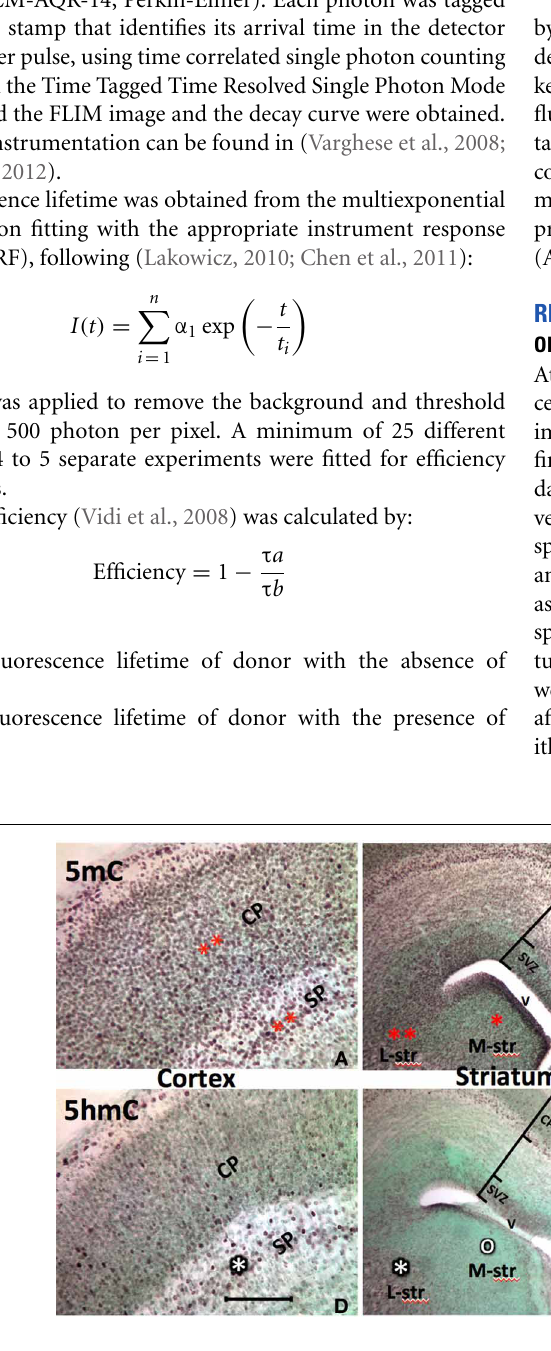
one red star area), and continue in the differentiating neurons in cortex (A) , lateral striatum (L-str, B ), and CA regions ( B , two red stars). The 5hmC arrives in the cells initiated for differentiation, and the level of 5hmC parallel with the stage of differentiation, e.g., subplate > cortical plate (D) , lateral striatum (L-str) > medial striatum (M-str) ( E , white star), CA1 > neuroepithelium ( F , white star). Counterstaining, methyl-green (green color). SVZ, subventricular zone; CP, cortical plate; SP, subplate; NE, neuroepithelium; V, ventricle; DG, dentate gyrus. Scale bar: A and D = 100 μ m; B,C,E,F = 100 μ